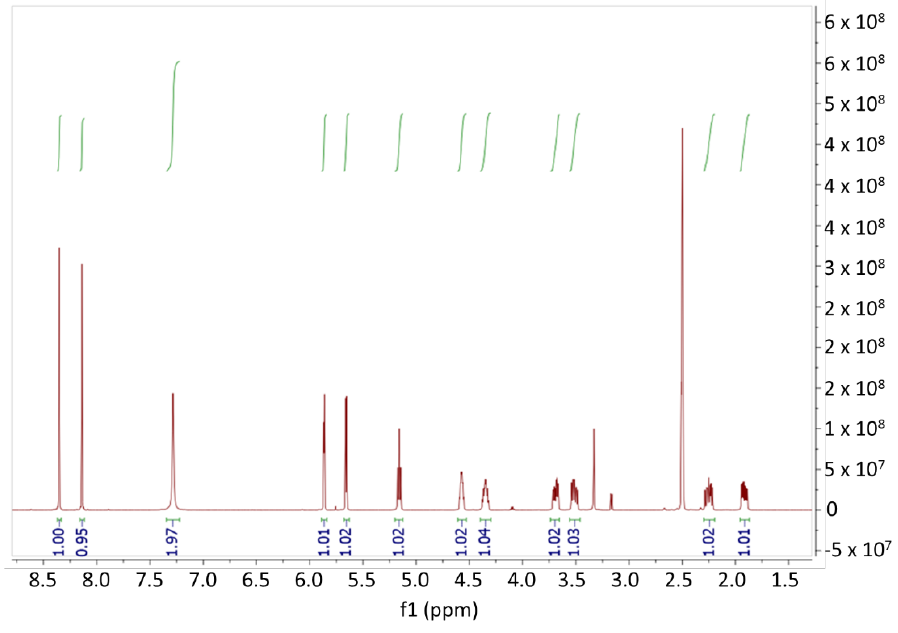
Figure 5. 1 H-NMR Spectrum of Cod23.